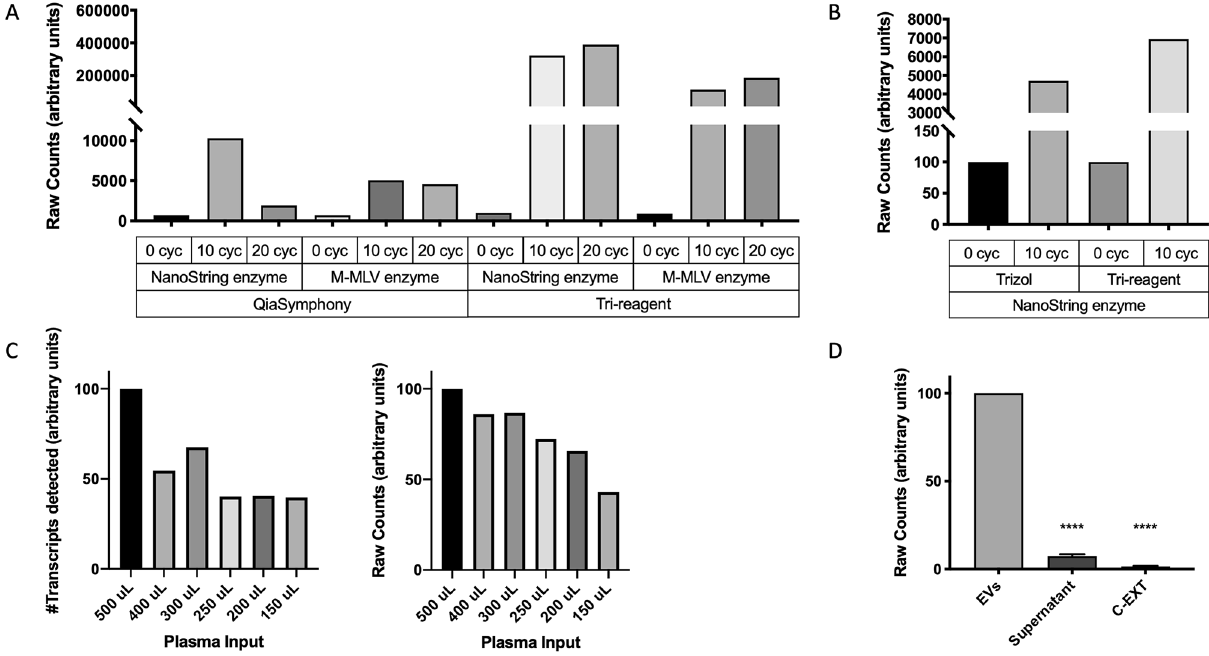
Figure 2. EV-RNA extraction, targeted pre-amplification and plasma input testing. ( A ) Total nCounter counts after automated (QiaSymphony) versus manual (TRI reagent) RNA extraction from an EV-enriched pellet. Two different retrotranscriptases (NanoString versus M-MLV) and three pre-amplification conditions (0, 10 and 20 cycles) were tested. Results were normalized to the counts corresponding to 0 cycles. ( B ) Total nCounter counts after TRIzol LS versus TRI reagent manual RNA isolation from an EV-enriched pellet. Results were normalized to the counts corresponding to 0 cycles. ( C ) Effect of input plasma volume (150–500 μL) on the final number of transcripts detected (left) or total nCounter counts (right) Results were normalized to the counts corresponding to 500 μL plasma. ( D ) Total nCounter counts of different fractions obtained during EV enrichment of plasma (EVs vs. supernatant p < 0.0001 in a one-way ANOVA with Dunnett’s multiple comparisons test; EVs versus C-EXT p < 0.0001 ). Cyc, cycles; EVs, extracellular vesicles; C-EXT, extraction